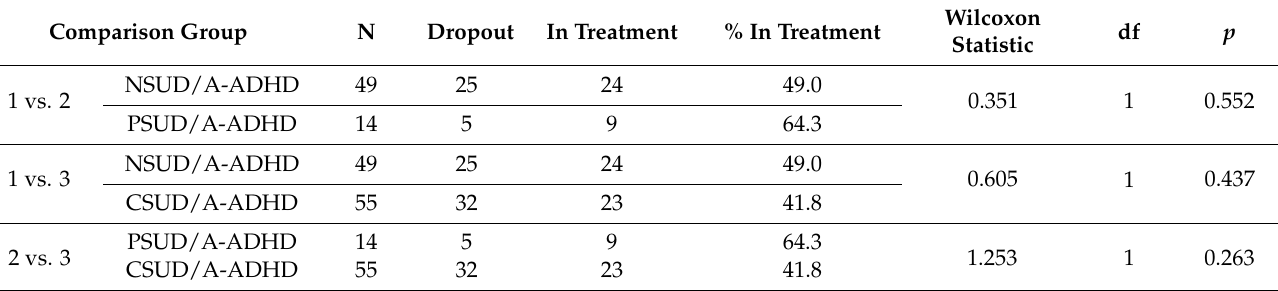
Table 2. Retention in treatment of 118 A-ADHD outpatients.